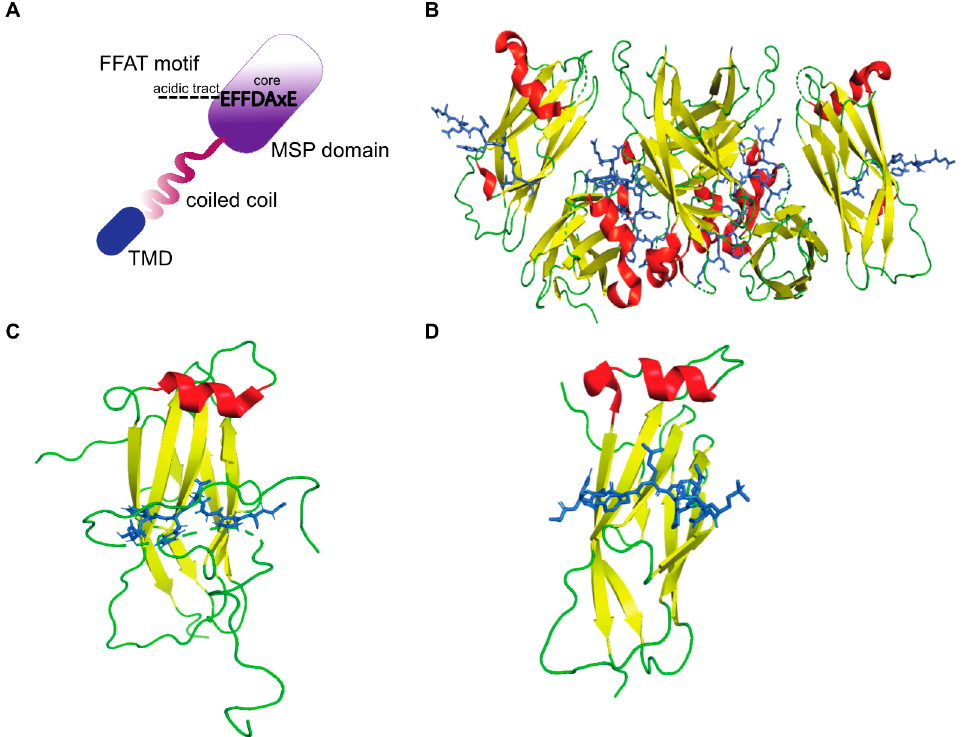
Figure 2. The structure of VAP-FFAT complexes. ( A ) Schematic representation of a conventional FFAT motif binding the MSP domain of VAP. The electropositive surface of the MSP domain binds the core residues of the FFAT motif, and the dotted lines represent the acidic tract. ( B ) The crystal structure of rat MSP-VAPA in complex with the ORP1 FFAT motif as described by Kaiser et al. [19] (PDB ID: 1Z9O). A tetramer formed by MSP-FFAT complex is shown. ( B – D ) The MSP domain is represented as ribbons (red: helix, yellow: β -sheet, green: loop), and the FFAT motif is represented as sticks (blue) that bind across the MSP domain. ( C ) The crystal structure of human MSP-VAPA in complex with OSBP-FFAT as described by Furuita et al. [51] (PDB ID: 2RR3). ( D ) Structure of human-MSP-VAPA in complex with STARD3 FFAT as described by Di Mattia et al. [52] (PDB ID: 6TQR).